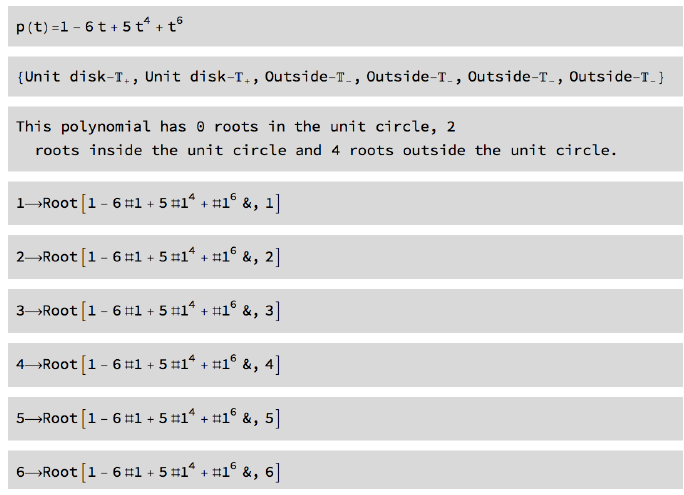
Figure 37. Output given by the [ARoots]